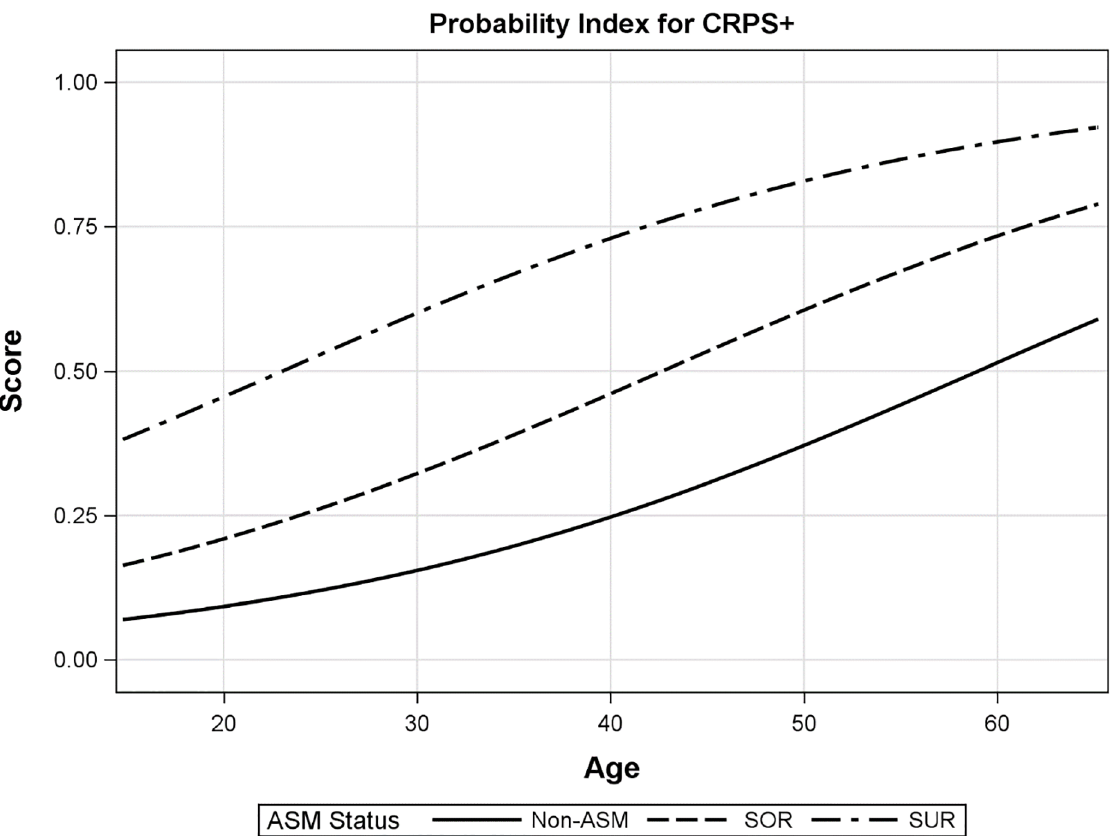
Fig 1. The risk probability for CRPS by SRQ-IS score. Non-SMD—no sensory modulation dysfunction; SOR—sensory over- responsiveness; SUR—sensory under-responsiveness. The risk index probability for CRPS takes into account the type of the sensory responsiveness i.e. over- or under-responsiveness (assessed by the SRQ-IS) and the person’s age (age is a continuous variable, so the fitted line can extend beyond the actual data).